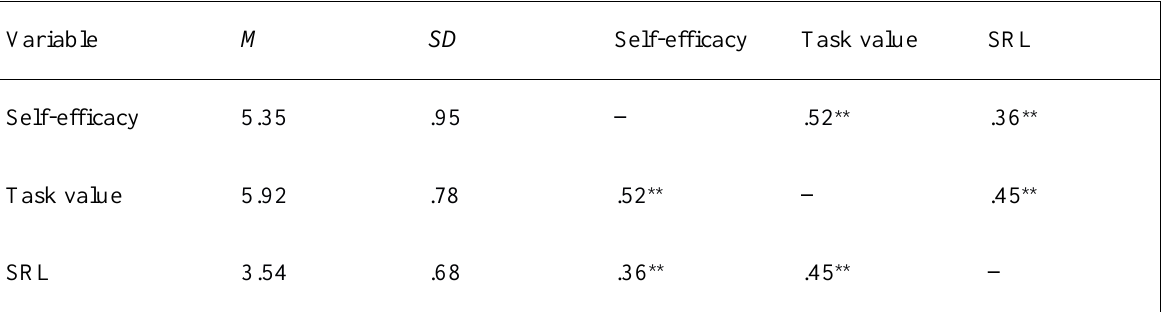
Means, Standard Deviations, and Pearson’s Correlations for Self-Efficacy, Task Value, and Self- Regulated Learning Variable M SD Self-efficacy Task value SRL Self-efficacy 5.35 .95 — .52 ** .36 ** Task value 5.92 .78 .52 ** — .45 ** SRL 3.54 .68 .36 ** .45 **